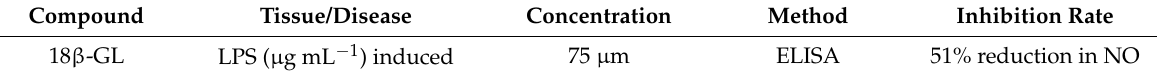
Table 1. A list of major bioactive compounds identified in licorice together with their therapeutical properties.